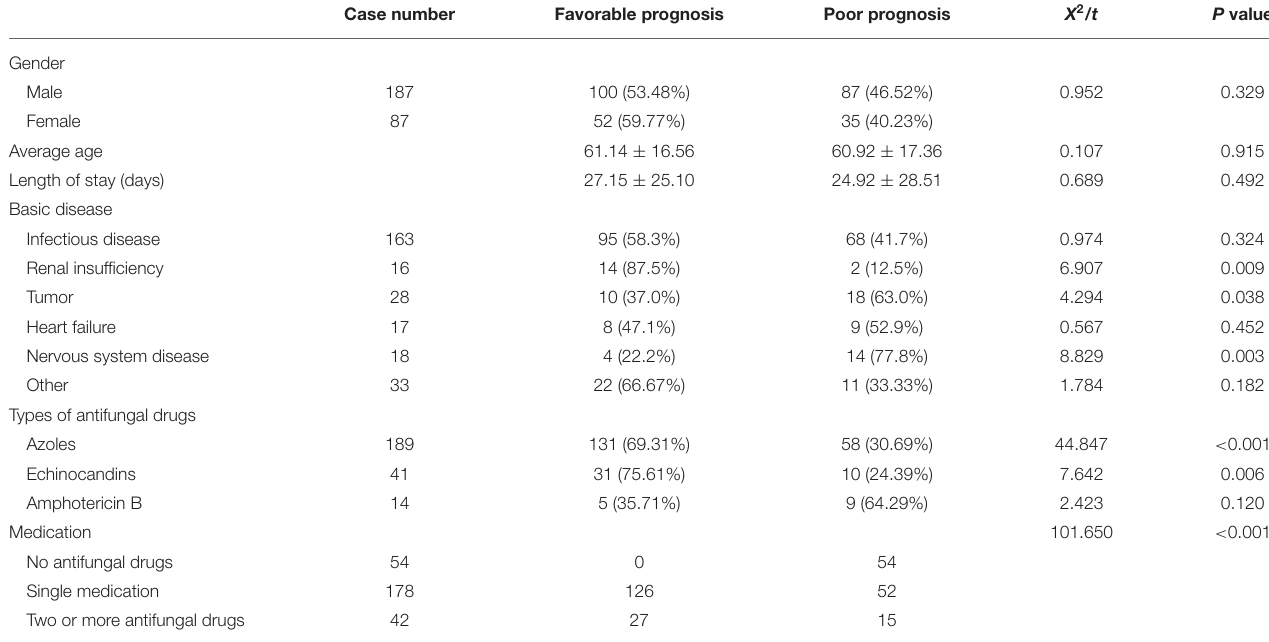
TABLE 3 | Comparison of different prognostic related factors in patients with deep fungal infections. Case number Favorable prognosis Poor